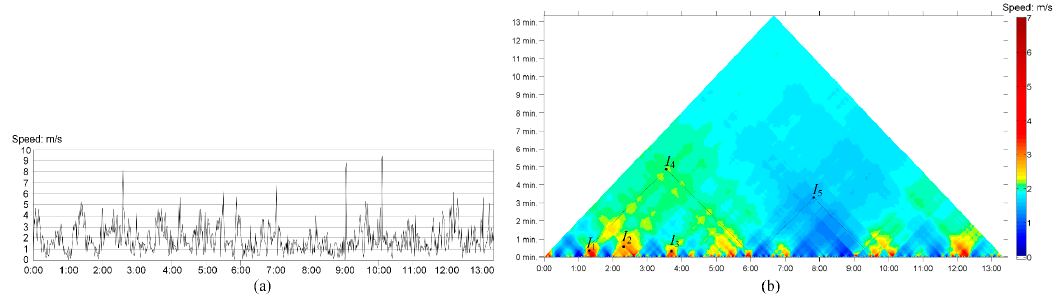
Figure 12. A comparison of the line chart ( a ) and TM representation ( b ) of the moving speed of a soccer player in a game (adapted from [18]).